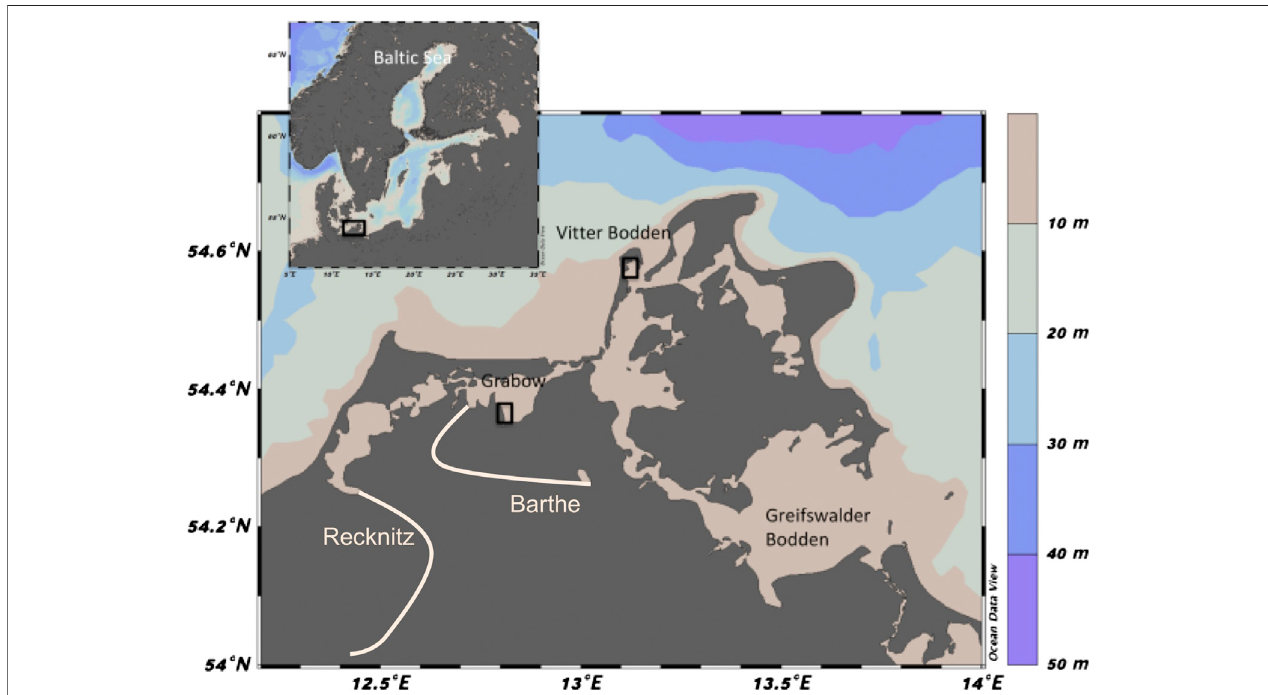
FIGURE 1 | Map of sampling sites at Grabow (Darß-Zingst Bodden chain) and Vitter Bodden (Westrügensche Bodden), southern coast of the Baltic Sea. Colors indicate water depths. White lines denote main riverine in fl ow of the rivers Recknitz and Barthe in this area. Maps were created with Ocean Data View (Schlitzer, 2018).